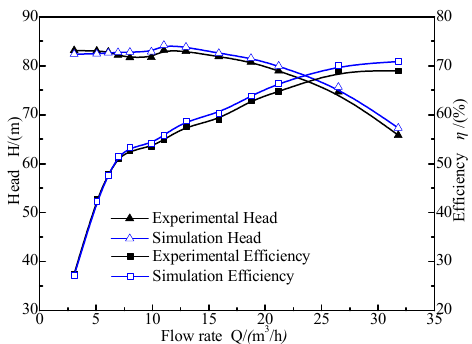
Figure 17. Performance under pure water condition.